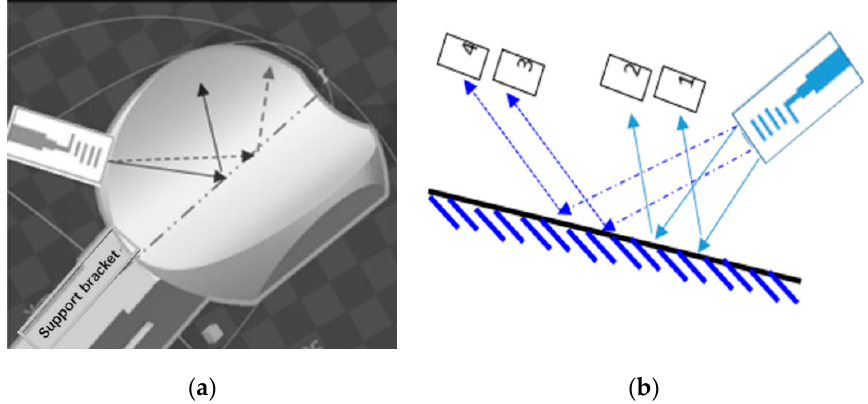
Figure 6. Optical paths in the parabolic reflector ( a ) 3D diagram ( b ) 2D diagram.